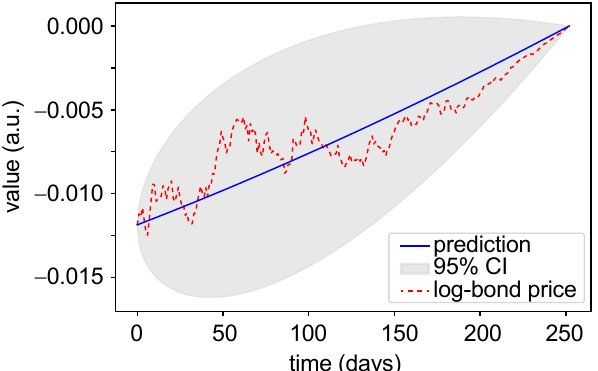
Figure 1. Illustration of a Gaussian process prior. Our task is to predict the unobserved log-bond-prices (red dotted line) with maturity T = 252. The blue line represents the prior mean and the shaded area represents the 95% confidence interval. Note that the initial value at time 0 is known, as well as the final value P ( T , T ) = 1, implying log P ( T , T ) =